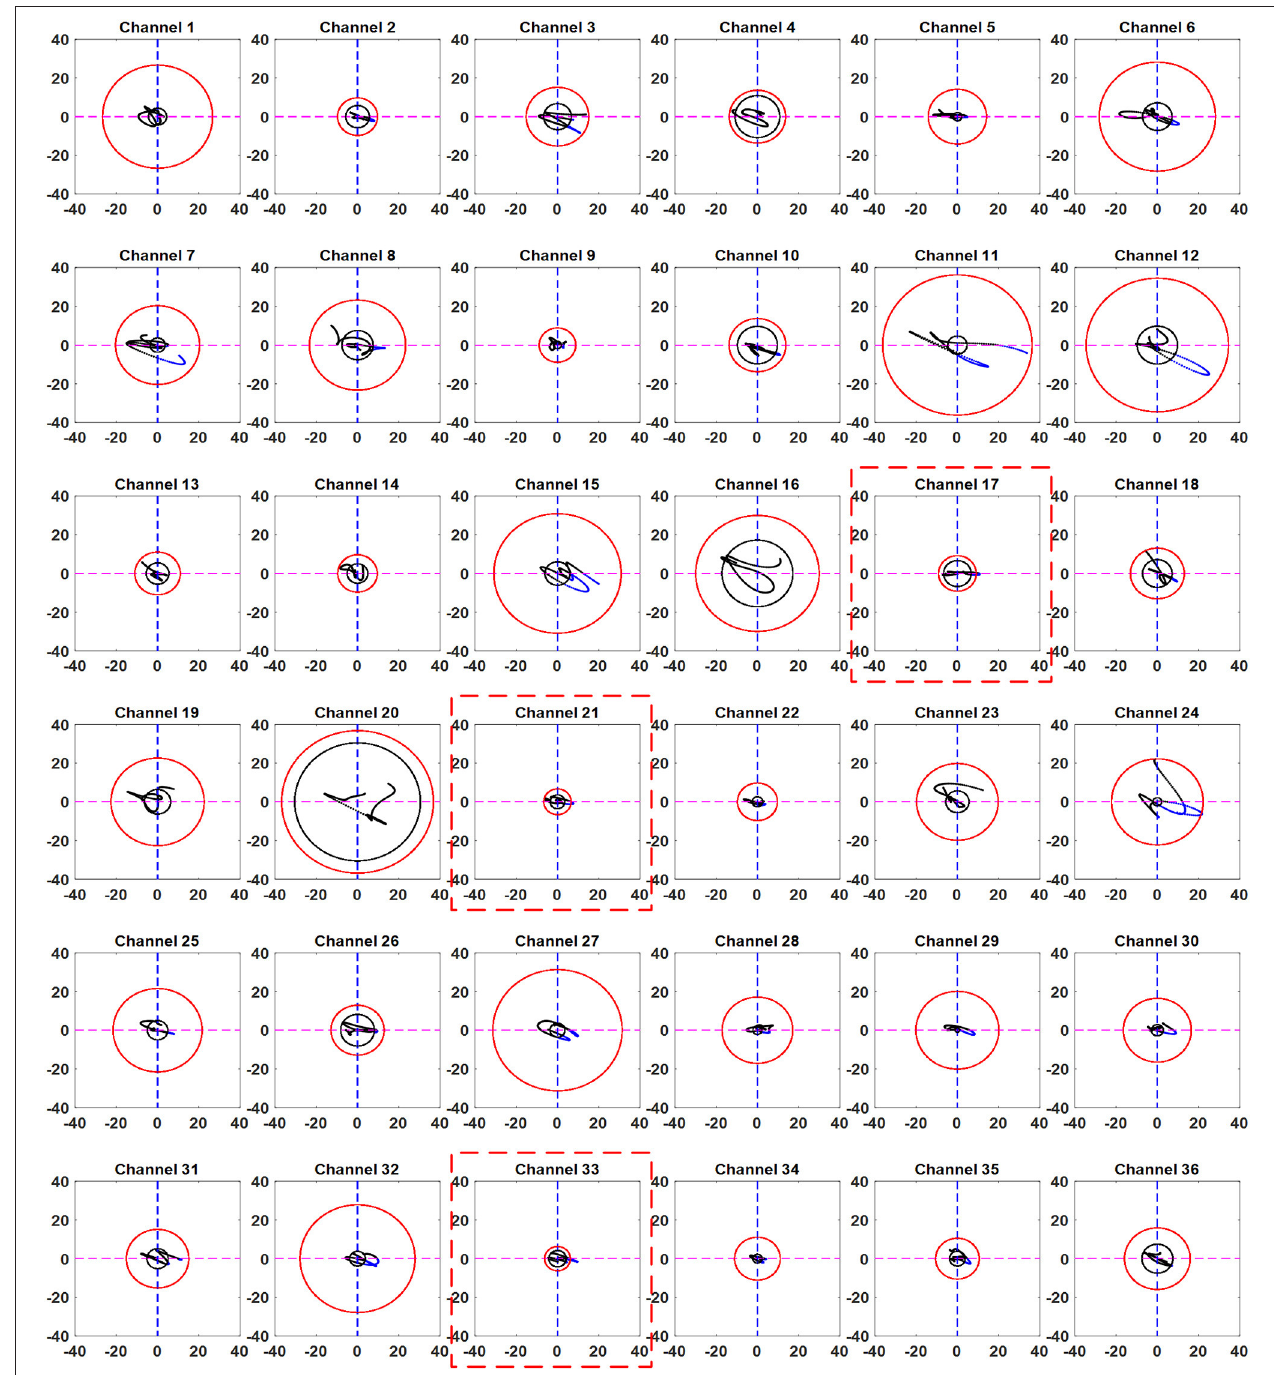
FIGURE 7 | Trajectories of all the channels obtained by the proposed scheme (Sub. 3, Trial 3): The red dotted boxes show the channels in which the trajectory has crossed the EEG-based circle (black) in the fourth quadrant and moved away from the resting state threshold circle (red). Examples of the trajectories of all trials for Ch. 21 of Subject 3 are shown in Figure 8 . It can be seen that the trajectories did not follow the same path in each trial. However, they moved from the smaller (black) circle to the larger (red) circle if the channel was